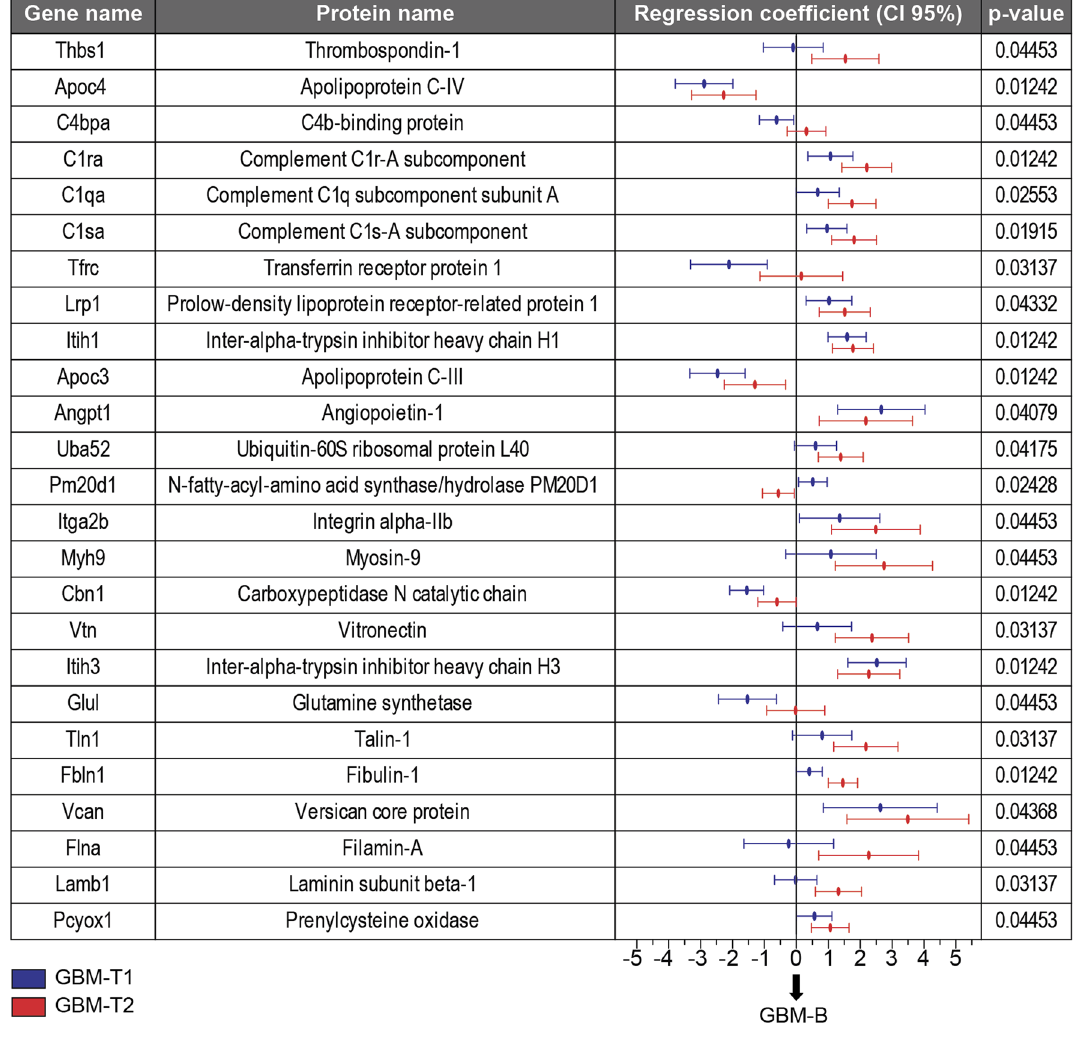
Figure 5. Linear mixed effects analysis of the longitudinal analysis datasets. List of the significantly deregulated proteins with relative p-values and regression coefficients. The regression coefficients (GBM-T1 in blue and GBM-T2 in red) are plotted with a confidence interval of